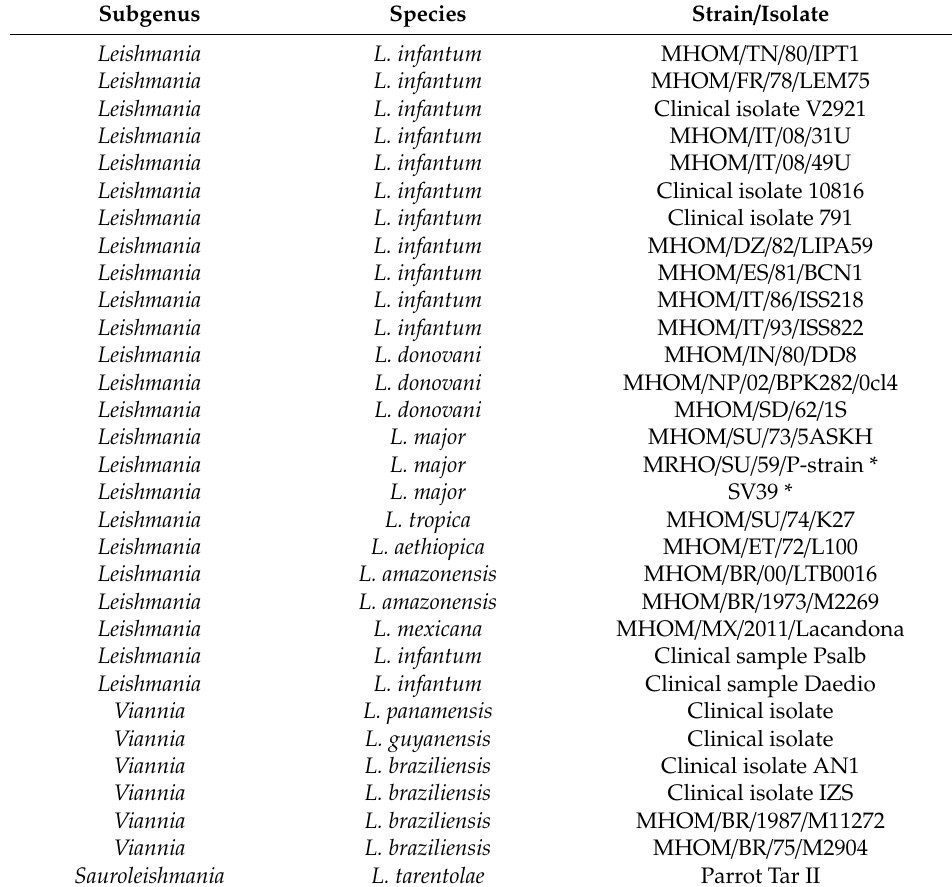
Table 1. Leishmania spp. reference strains, clinical isolates and clinical samples used in this